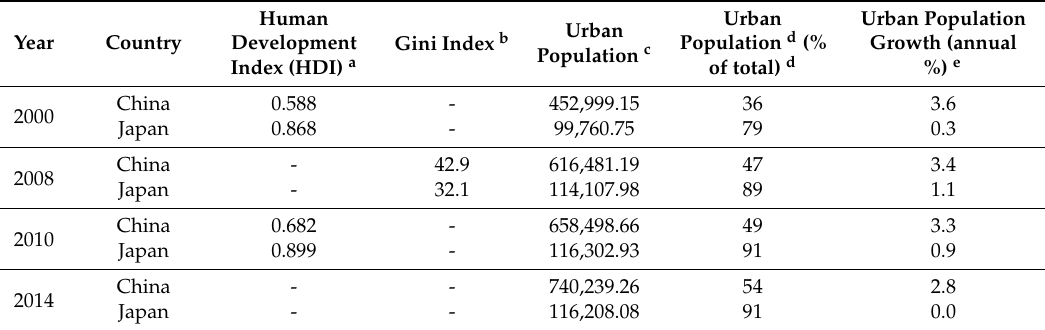
Table 1. The descriptive socioeconomic indicators of China and Japan.